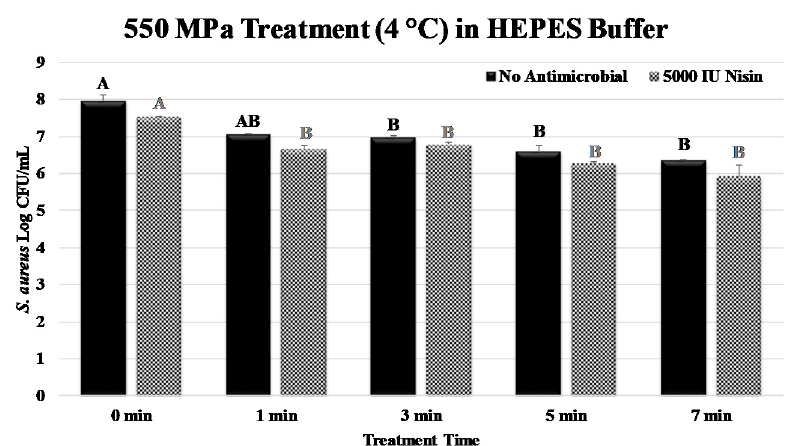
Figure 3. Inactivation of S. aureus by elevated hydrostatic pressure (550 MPa at 4 °C) in the presence of 5000 IU of nisin. Values followed by different upper-case letters are statistically ( p < 0.05) different than each other (pair-wise comparisons, Tukey-adjusted ANOVA). For samples treated without antimicrobial (solid bars) and those treated in the presence of nisin (patterned bars) statistical analyses are presented separately by upper-case letters with different colors.